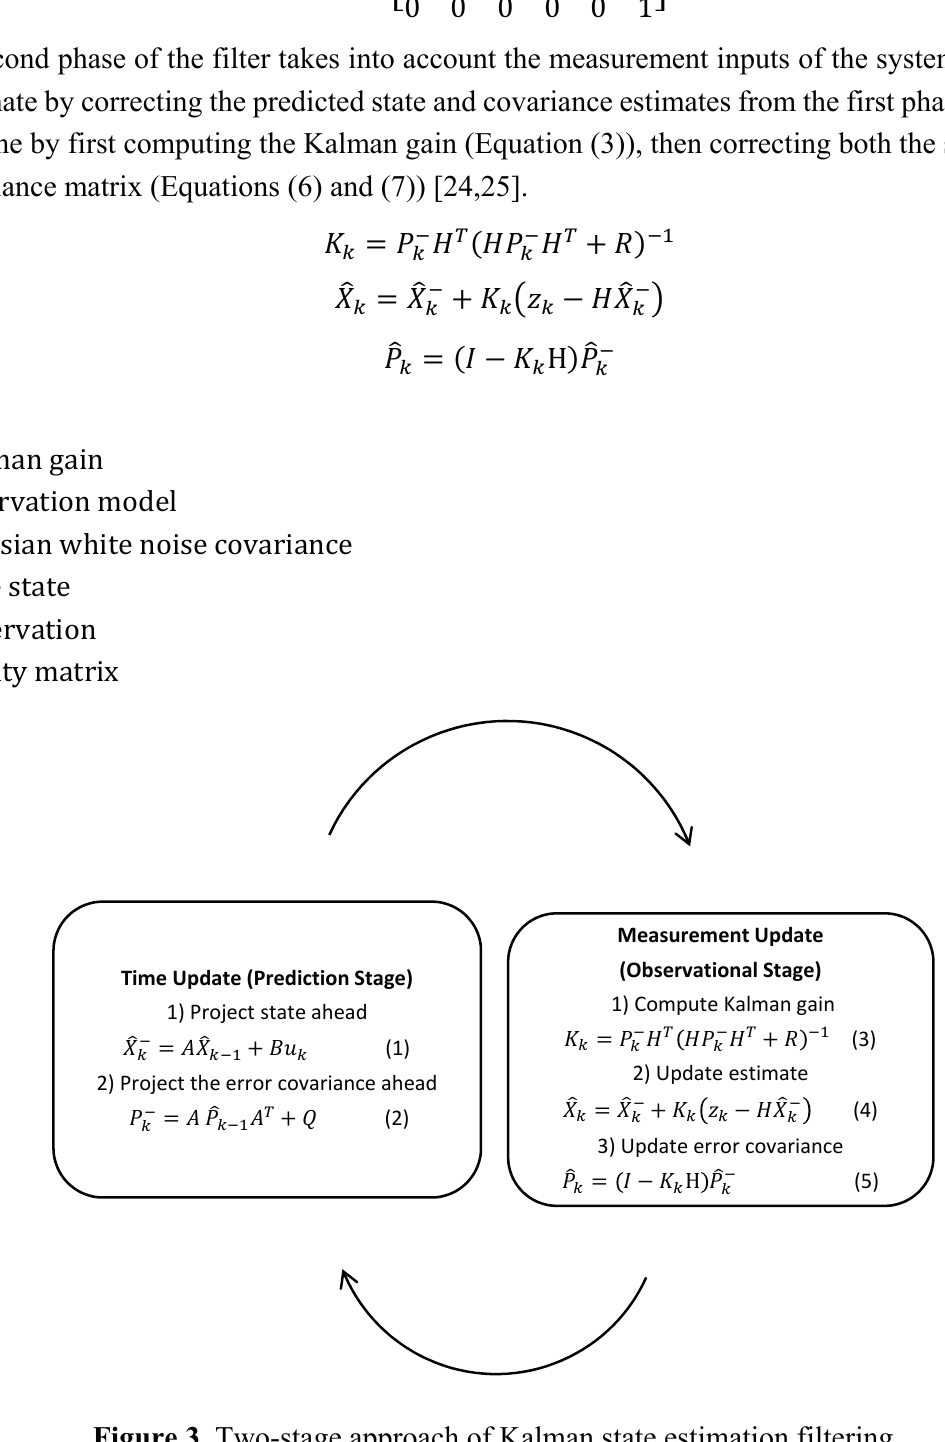
Figure 3. Two-stage approach of Kalman state estimation